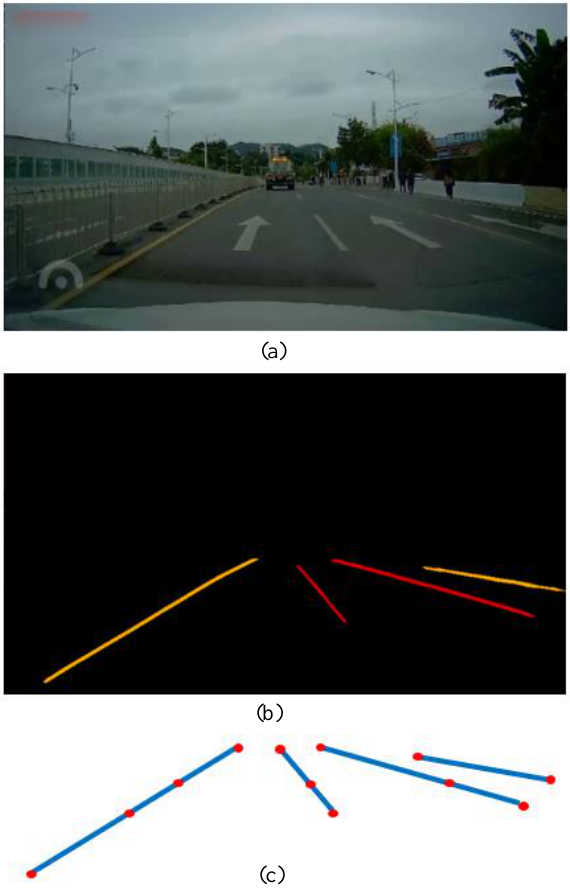
Figure 5 . Pipeline of lane detection. (a) Original image. (b) Segmentation mask. (c) Lanes expressed as piecewise